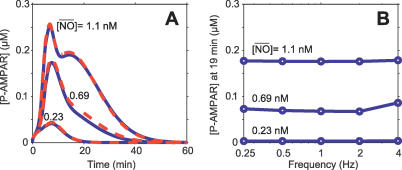
Importance of the Time-Averaged Concentration of NO(A) Time course of AMPAR phosphorylation induced by continuous exposure to NO (red dotted line) or by NO pulses (blue solid line) equivalent in time-averaged concentrations (0.23 nM, 0.69 nM, and 1.1 nM from bottom to top).(B) [P-AMPAR] at 19 min is plotted against the frequencies of NO pulses whose 1-s–averaged concentration was 0.23 nM, 0.69 nM, or 1.1 nM (from bottom to top).